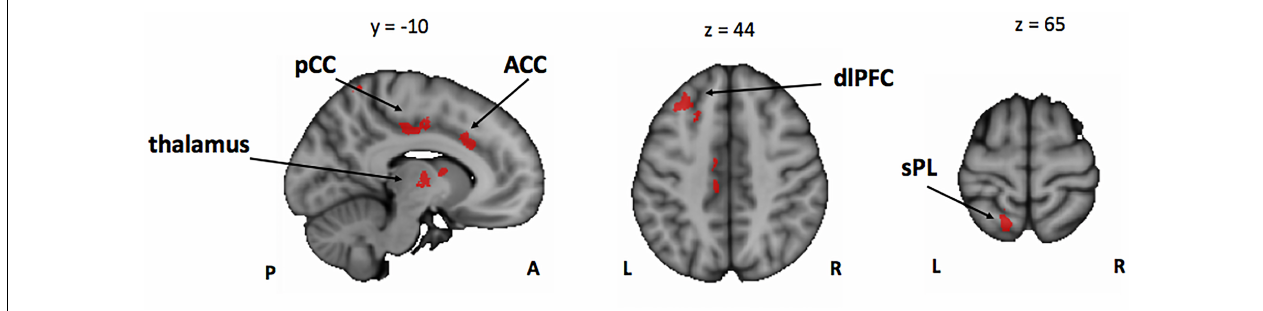
FIGURE 4 | Conjunction analysis between the Mus > Cont contrasts of the encoding phase [ASA > P], [VSA > P], and [DA > P] contrasts. Mus, musically trained children; Cont, control children; ASA, auditory selective attention; VSA, visual selective attention; DA, divided attention; P, passive; pCC, posterior cingulate cortex; ACC, anterior cingulate cortex; dlPFC, dorsolateral prefrontal cortex; sPL, superior parietal lobe. TABLE 5 | Peaks of activity of (1) group differences (Mus > Cont children) for the correlation between correct responses on AMT and the contrasts [VSA > P] and (2) musicians for the correlation between years of training and the [ASA > P] contrast. Area x y z Z-score Cluster size Corrected p -value Mus > Cont for correlation between correct responses on AMT and VSA > P Right supplementary motor cortex